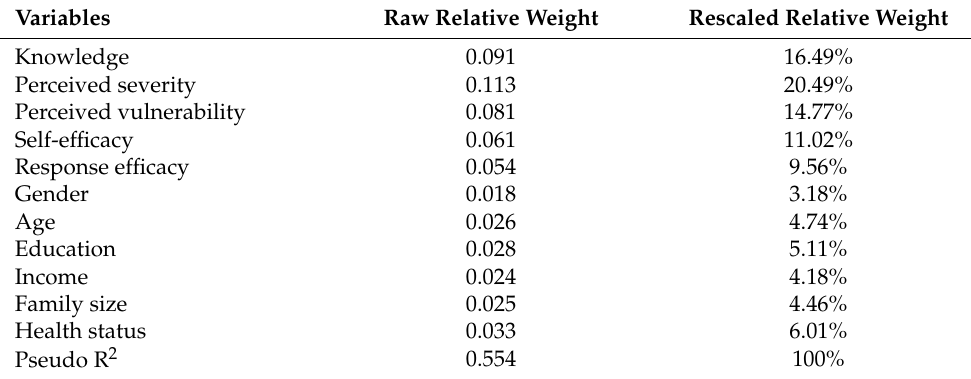
Table 8. Relative importance weights of the determinants of residents’